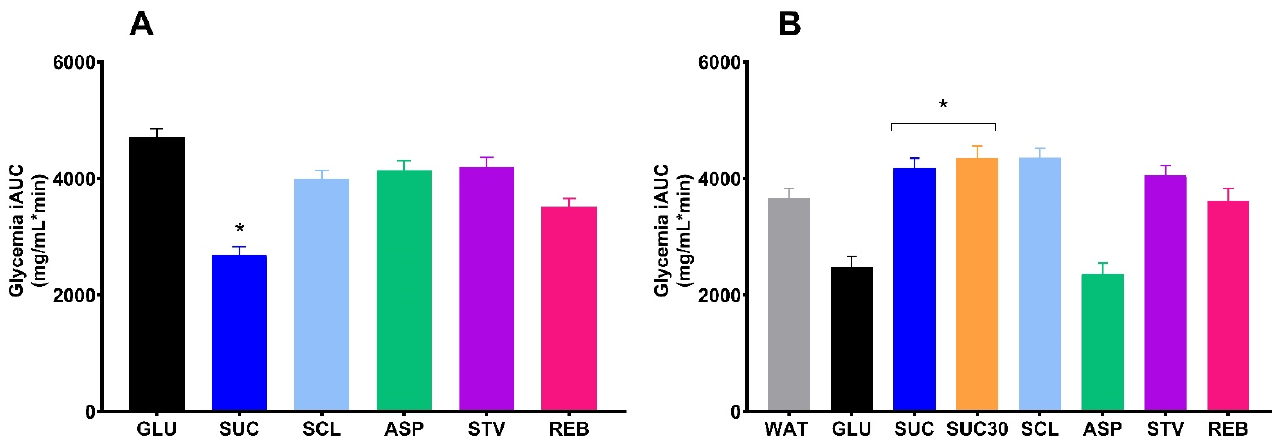
Figure 7. Effects of NNS on glycemia iAUC after the interventions adjusted by the baseline glycemia iAUC values in ND ( A ) and HFD-fed rats ( B ). Data are expressed as mean ± SEM. ( n = 6–8 per group). No significant differences of NNS were found in either group after ANCOVA analysis. In ND, SUC vs. GLU * p < 0.05. In HFD, SUC and SUC30 vs. GLU * p < 0.05. WAT, water; GLU, glucose; SUC, sucrose; SUC30, 30% sucrose; SCL, sucralose; ASP, aspartame; STV, stevia; REB, reb